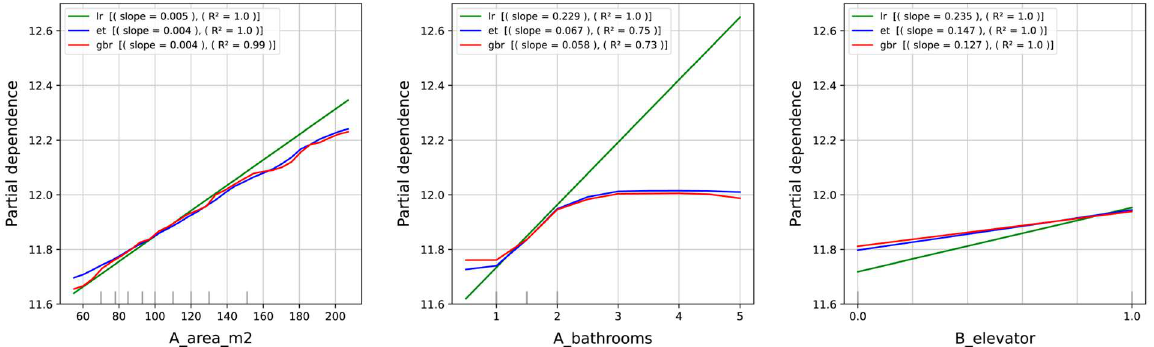
Figure 17. One-way partial dependence plots for the surface area, number of bathrooms, and elevator availability obtained with the lr , et , and gbr algorithms.